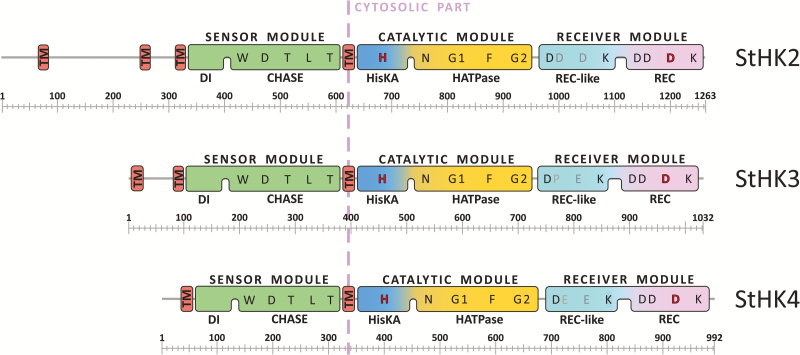
Module/domain structures of the predicted potato CK receptors. Protein domains: CHASE, cyclase/histidine kinases associated sensory domain (Steklov et al., 2013); DI, dimerization interface; HATPase, adenosine triphosphatase domain; HisKA, histidine kinase A domain; Rec, receiver domain; Rec-like, receiver-like domain; TM, transmembrane segment. Conserved amino acids and consensus motifs (N, G1, F, G2) are indicated. According to conventional terminology, the catalytic module consists of a dimerization and histidine phosphotransfer domain (DHpD), and catalytic and ATP-binding domain (CAD) (Mayerhofer et al., 2015; Pekárová et al., 2016). Scales at the bottom of the structures indicate the length in amino acid number.